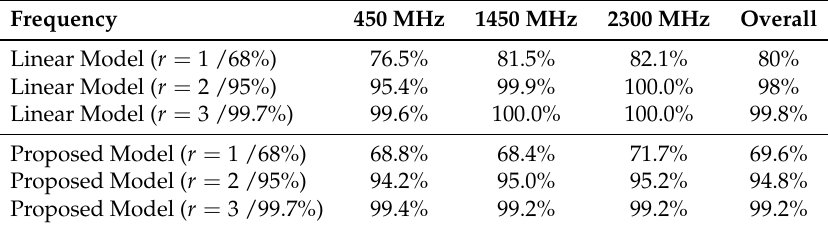
Table 4. Prediction coverage by different